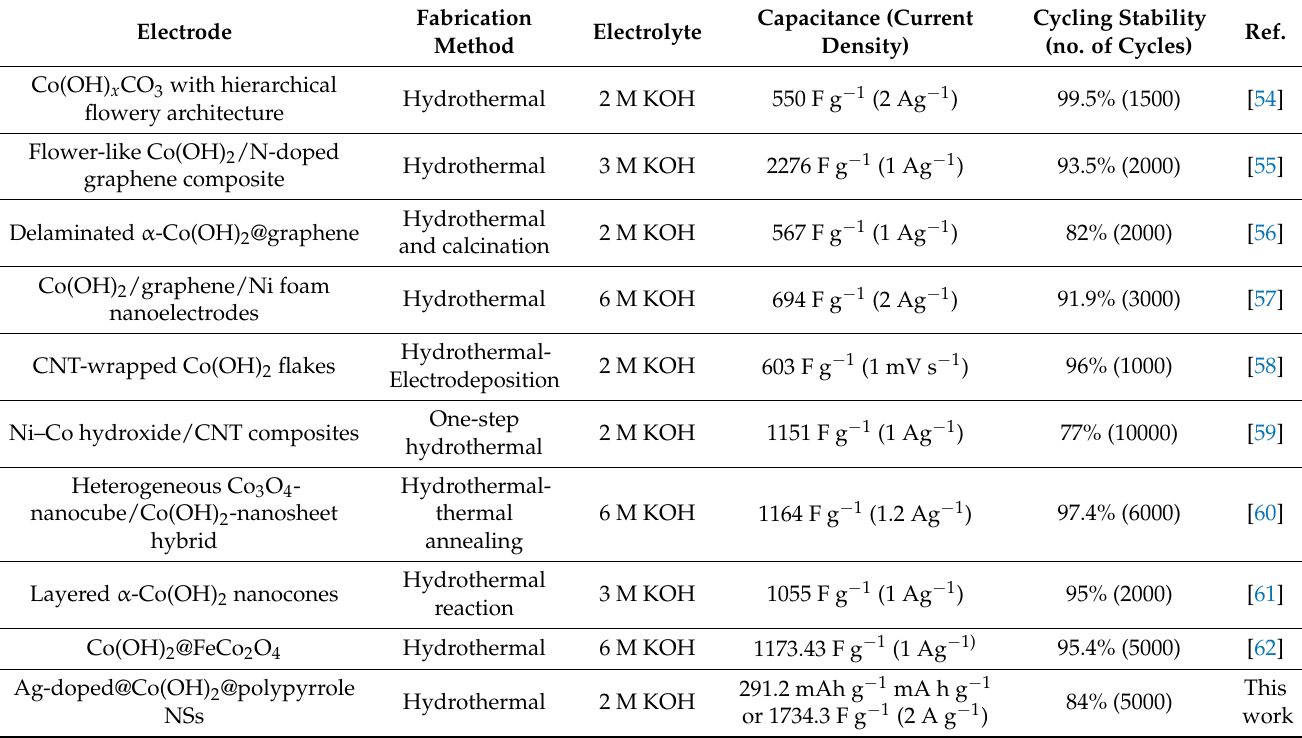
Comparison of specific capacity values of recently published metal oxides with multicomponent-based electrodes with our highly efficient Ag-doped@Co(OH) 2 @polypyrrole NS electrode in 3-electrode